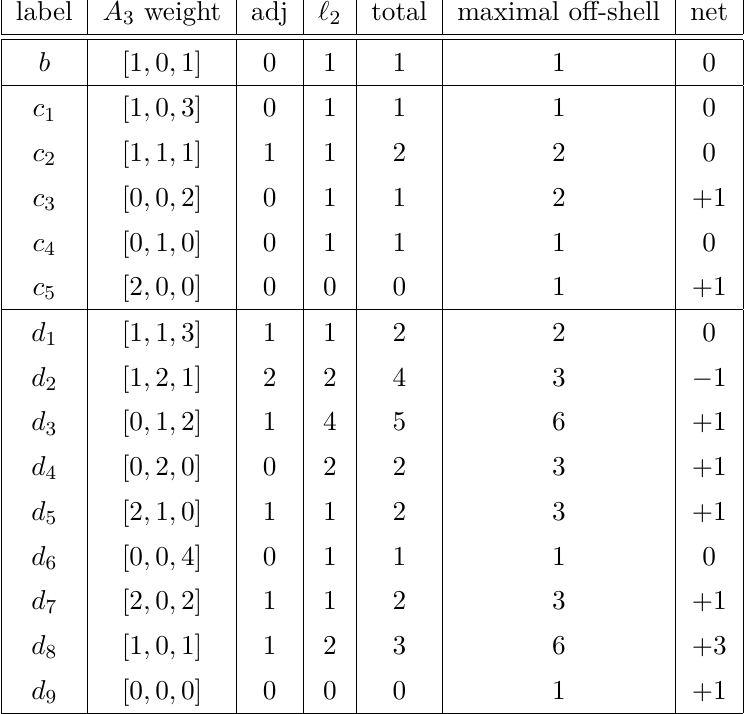
Table 3 . Extra fields from off-shell dualisation compared with A +++